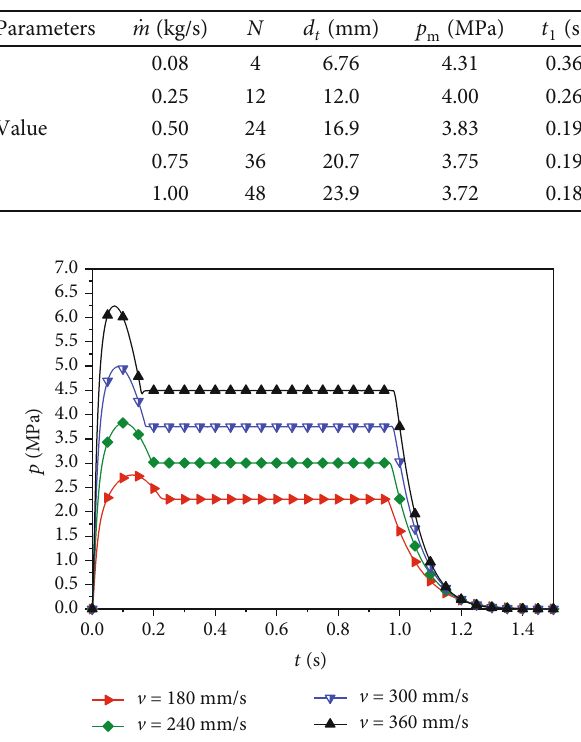
Figure 13: The pressure evolutions in the combustor for di ff erent fl ow velocities of the pasty